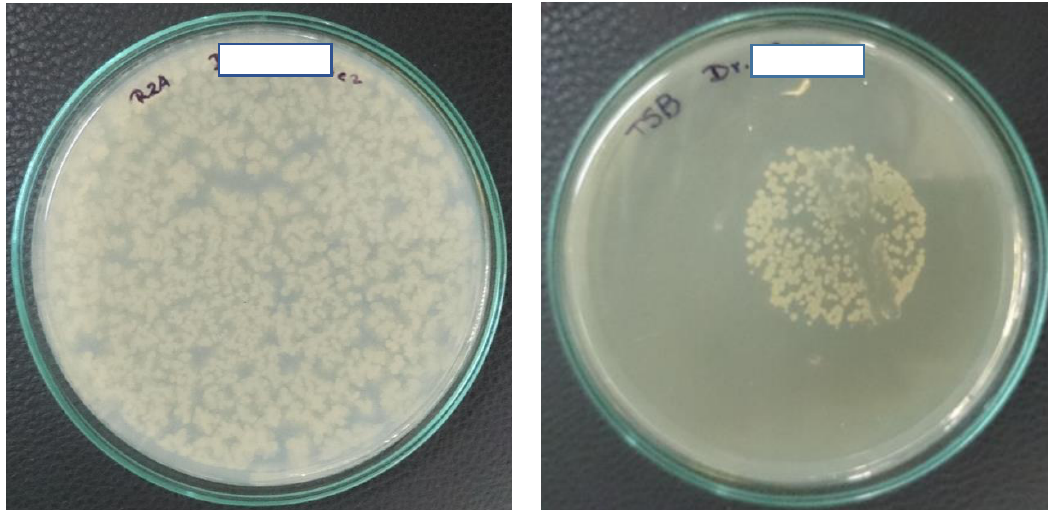
Figure 1. Examples of positive water cultures. On the left, 100 µL of water was plated on Reasoner's 2A (R2A) agar, and the Petri dish was incubated at 36 – 37 °C for 72 h. On the right is the result of a water sample that was positive for mycobacteria after 7 days of growth at 37 °C. An uncountable number of mycobacteria was isolated from 200 mL of DUWL water. The mycobacteria were isolated using the membrane filtration technique with a 0.45 µm nitrocellulose filter with a diameter of 47 mm, that was placed upside down on TSB agar with glycerol and an antibiotic mix, and again removed after two days of preincubation (see Materials and Methods). The visible streak through the colonies on this plate is where a loop full of bacteria had been taken for confirmation of the presence of acid-fast bacilli using the Ziehl – Neelsen staining technique. The mycobacteria on this plate were identified with the PCR-restriction enzyme analysis (PRA) technique as M. abscessus . For the purpose of anonymity, the name of the dentist on the Petri dish has been hidden.